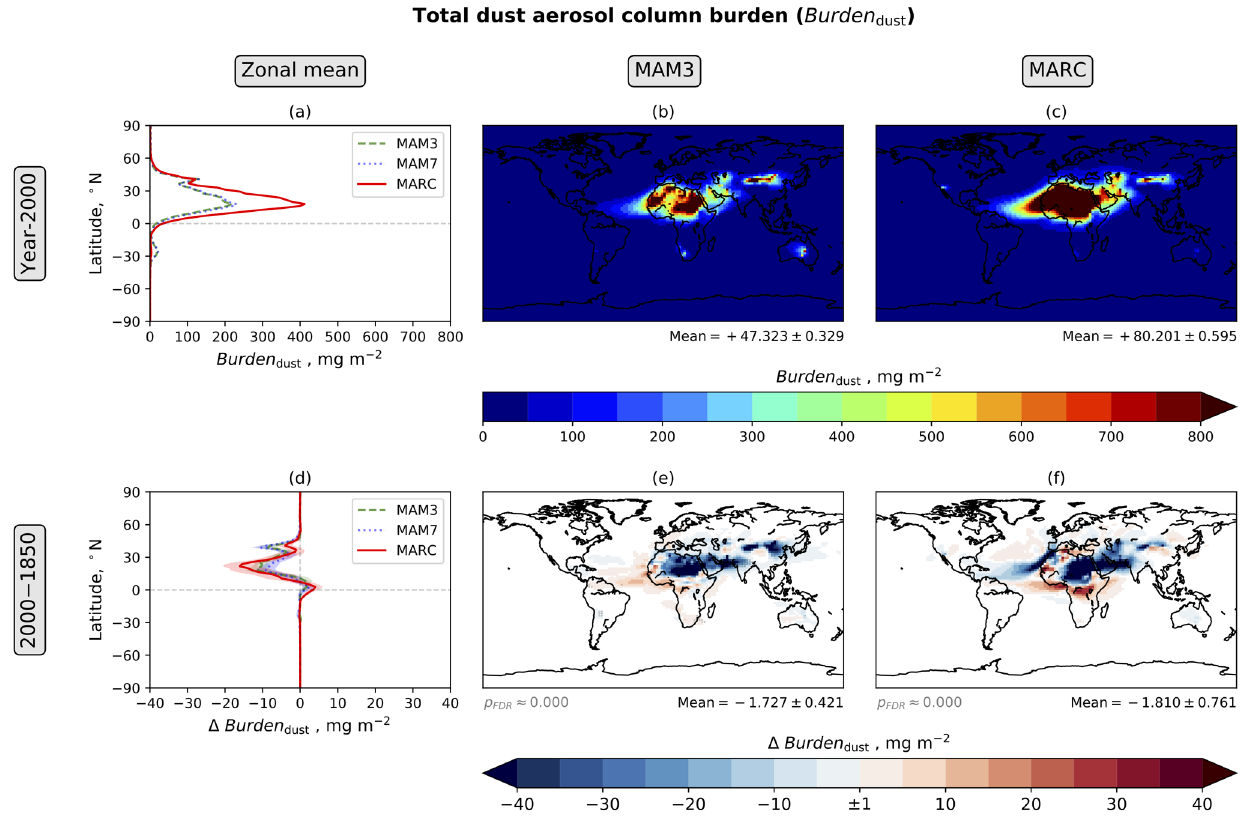
Figure 6. Annual mean dust aerosol burden (Burden dust ). The figure components are explained in the Fig. 2